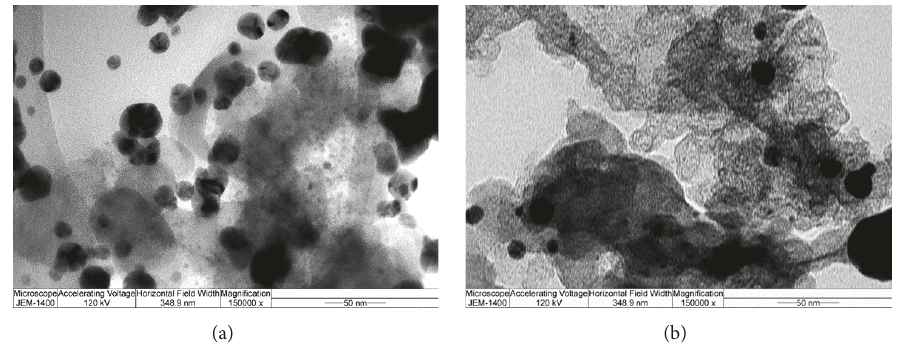
Figure 3: Representative TEM micrographs of Ag/C catalyst obtained from the colloid suspensions 214 (a) and 116